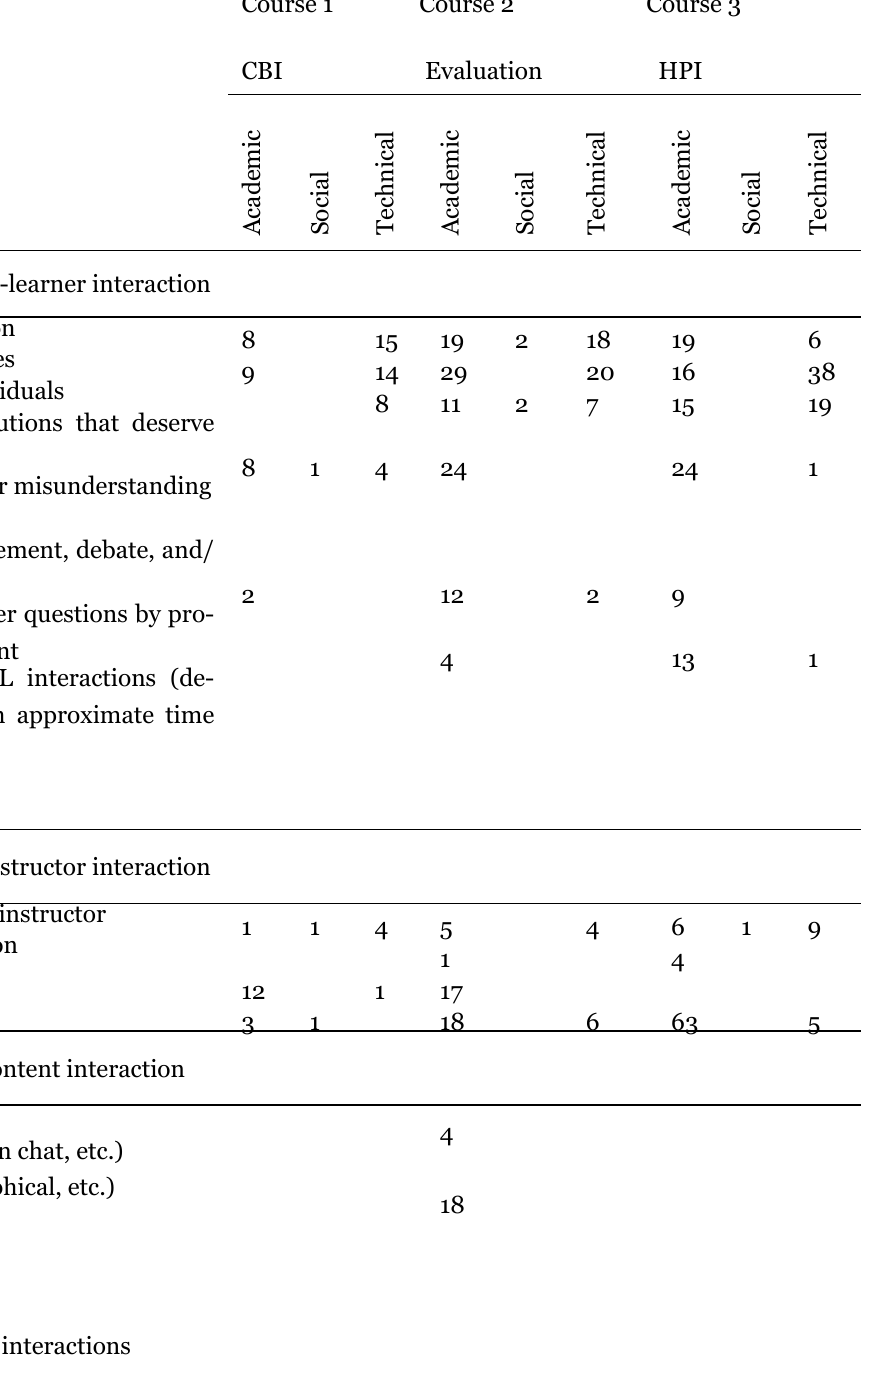
Archival Analysis of Interaction within Three Instructional Technology